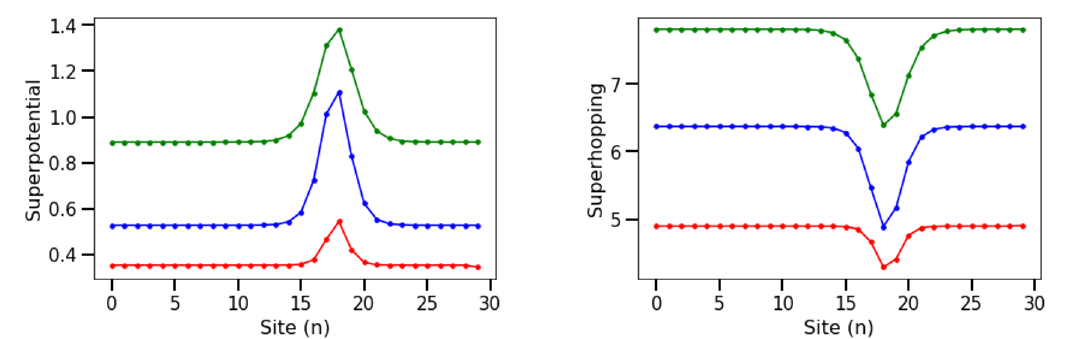
Figure 4 . A plot of the superpotential and the superhopping obtained from the discrete hyperbolic secant potential given in eq. (4.18) for a variety of asymptotic values of t and u . The boundary condition ∆ 2 = ∆ 2 was chosen, which results in non-topological soliton solutions shown. Note that ? 0 the chain is cut off after 30 lattice sites due to the exponential numerical instability caused from small deviation from ∆ ?